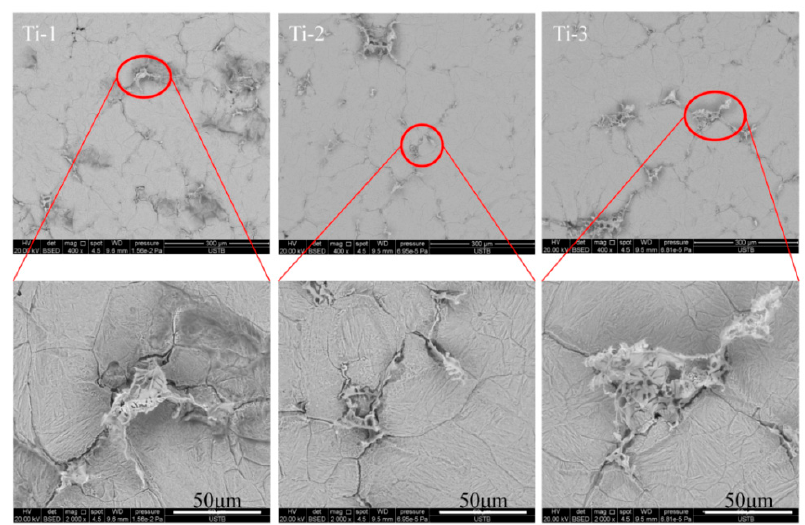
Figure 11. Three-dimensional morphologies of primary carbide in the samples.